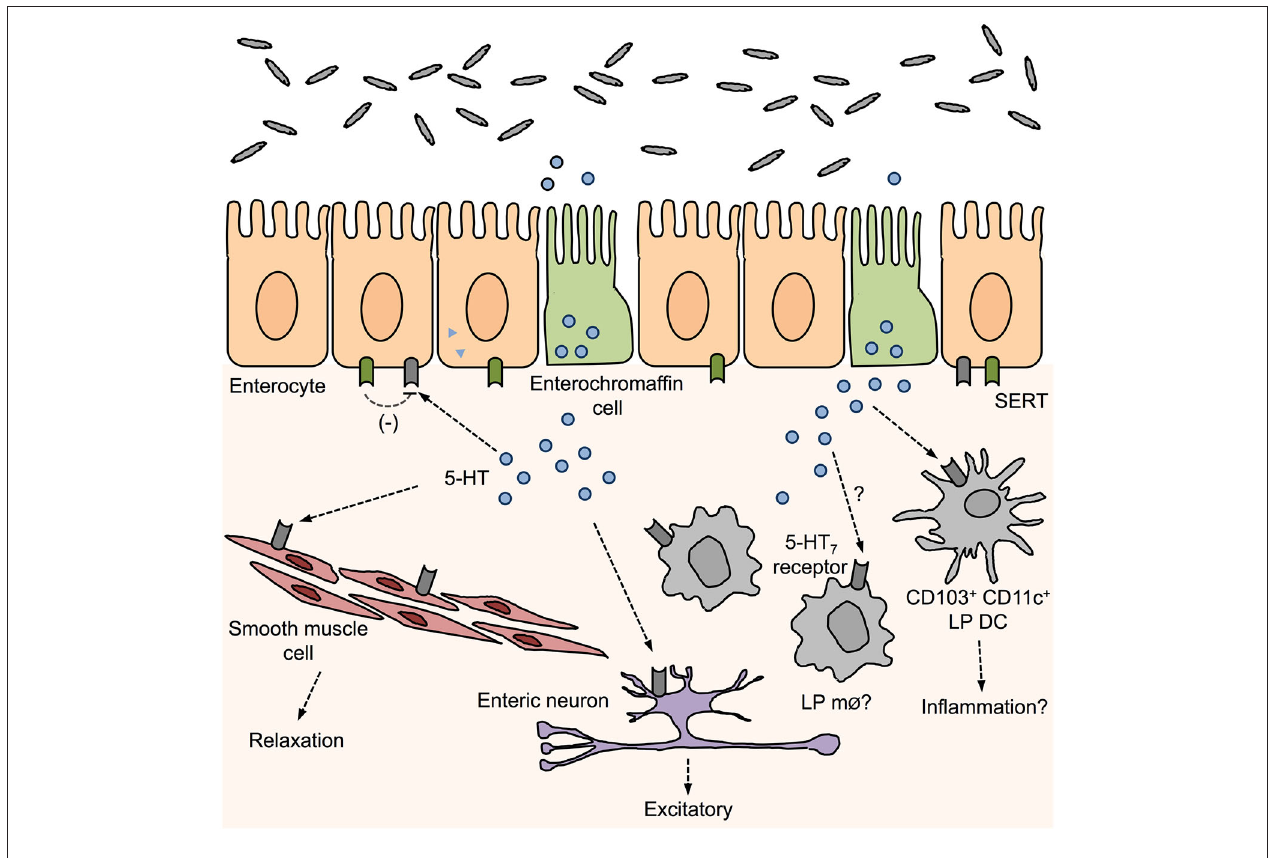
enterocytes, and immune cells. Activation of 5-HT 7 receptors can influence muscle tone, enteric neuron excitation, and have been proposed to inhibit SERT activity and promote inflammation by activation of LP dendritic cells